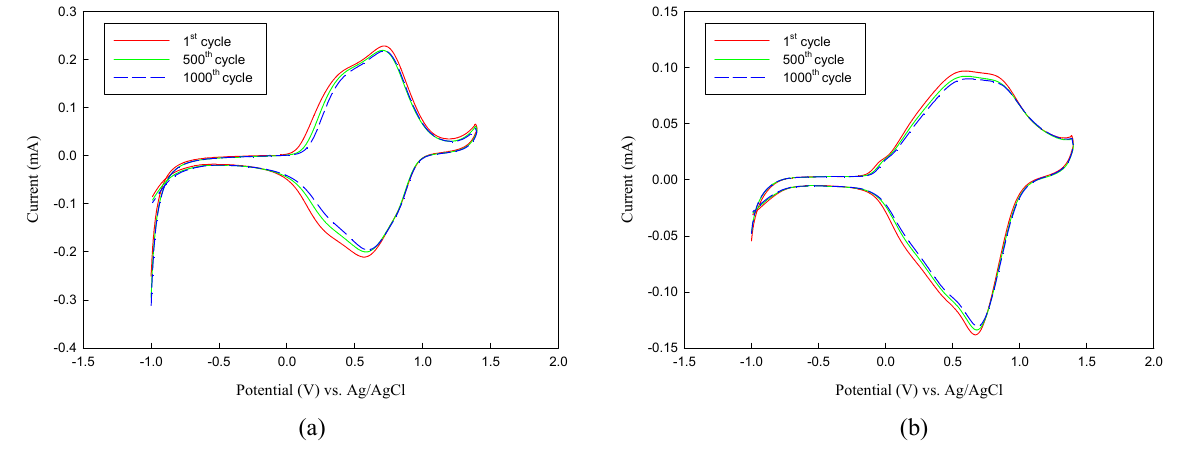
Figure 11. Cyclic voltammogram of: ( a ) P(TTPA- co -DIT)-1.0 V/PProDOT-Et 2 ECD; and ( b ) P(TTPA- co -BDTA)-1.0 V/PProDOT-Et 2 ECD as a function of repeated scans at 100 mV·s − 1 .